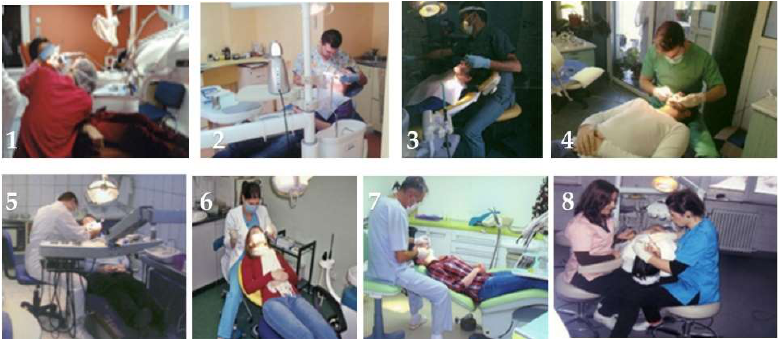
Figure 1. 1–8, photographs of working clinicians in different positions during dental procedures.